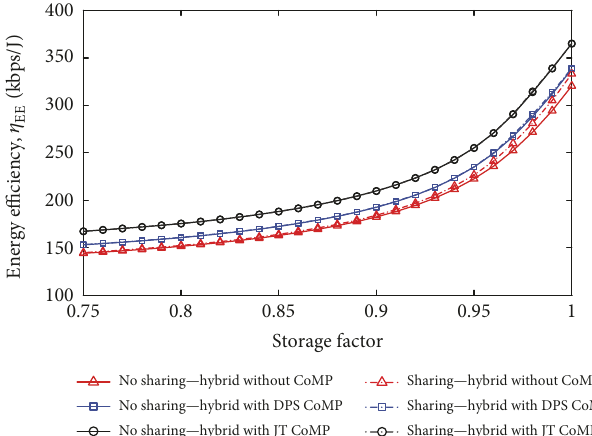
Figure 11: Variation of EE with storage factor with energy sharing considering equal solar capacity.